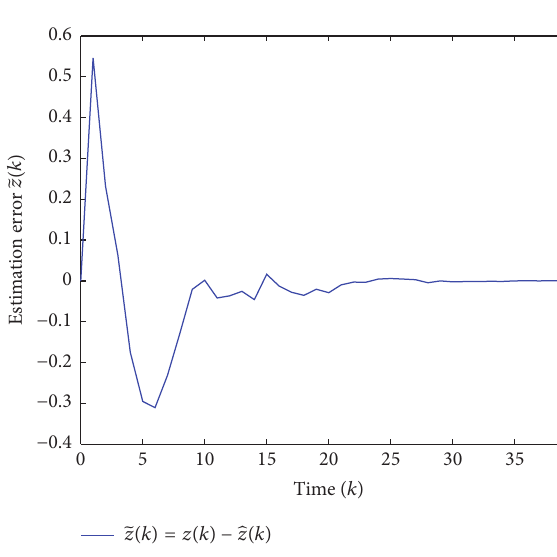
Figure 2: Real and ideal measurement outputs.